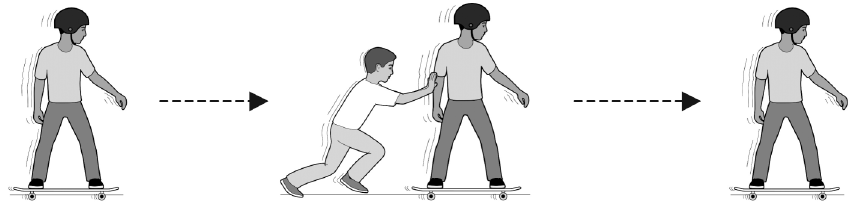
FIG. 5. Image from PSET C2A1 homework. Skateboarder moving to the right is subject to a short push.